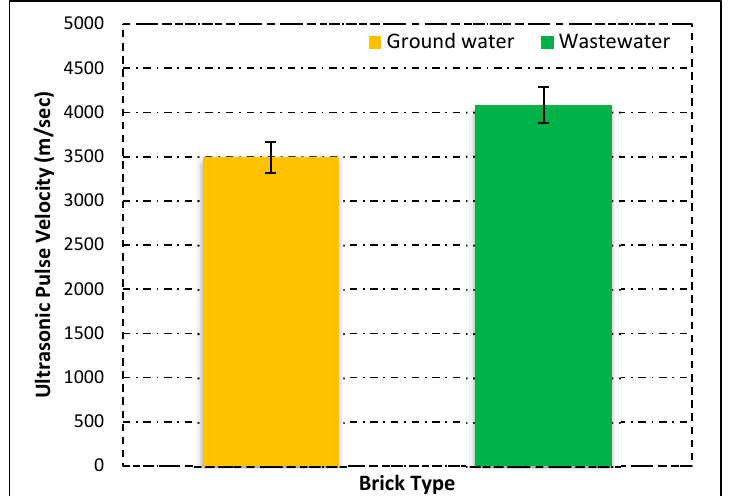
Figure 9. Ultrasonic Pulse Velocity of fired clay bricks.